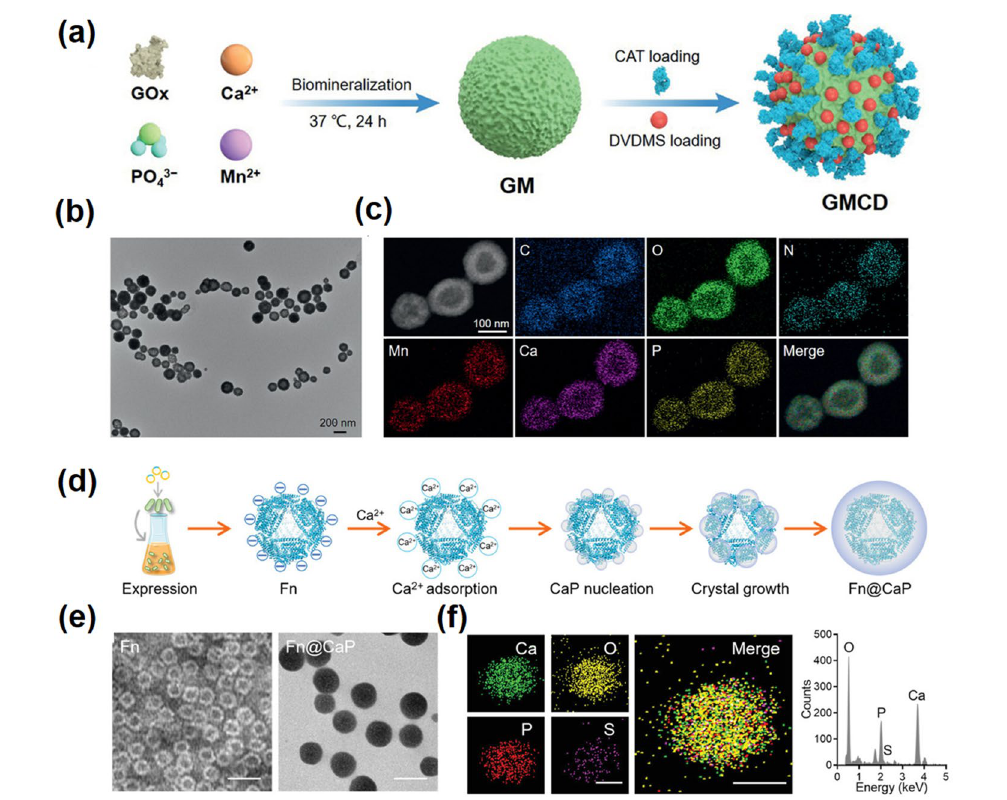
Fig. 4 Calcium phosphate-based nanomaterials. a Synthetic procedure of GMCD. b The TEM images of GM. c Elemental mapping of GM [68]. Copyright 2021, Wiley–VCH. d Synthetic process of the Fn@CaP nanoplatform. e TEM images of Fn and Fn@CaP. f Elemental mapping analysis (left panel) and energy dispersive spectroscopy (EDS) analysis (right panel) of Fn@CaP [70]. Copyright 2022,